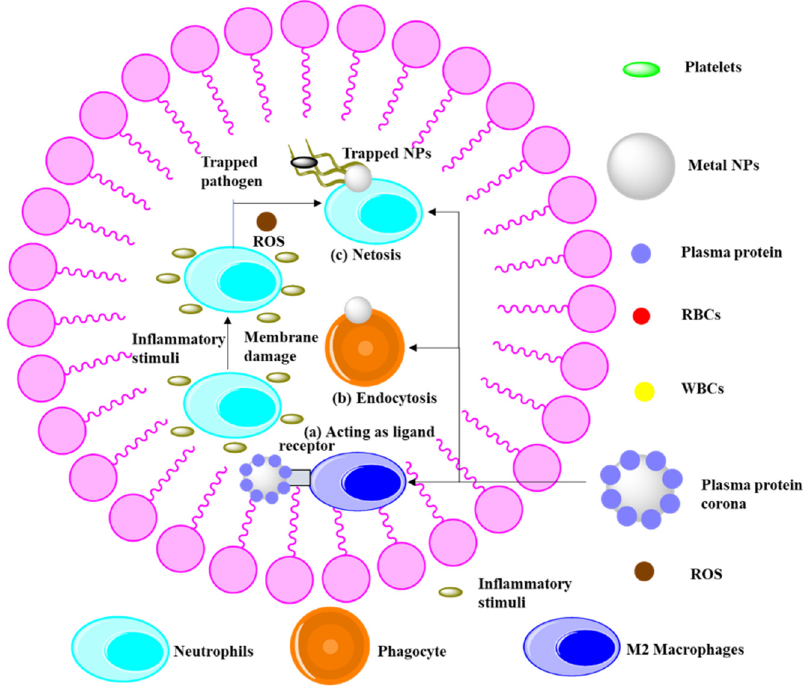
Figure 3. Anti-inflammatory mechanism adopted by various nanoparticles.